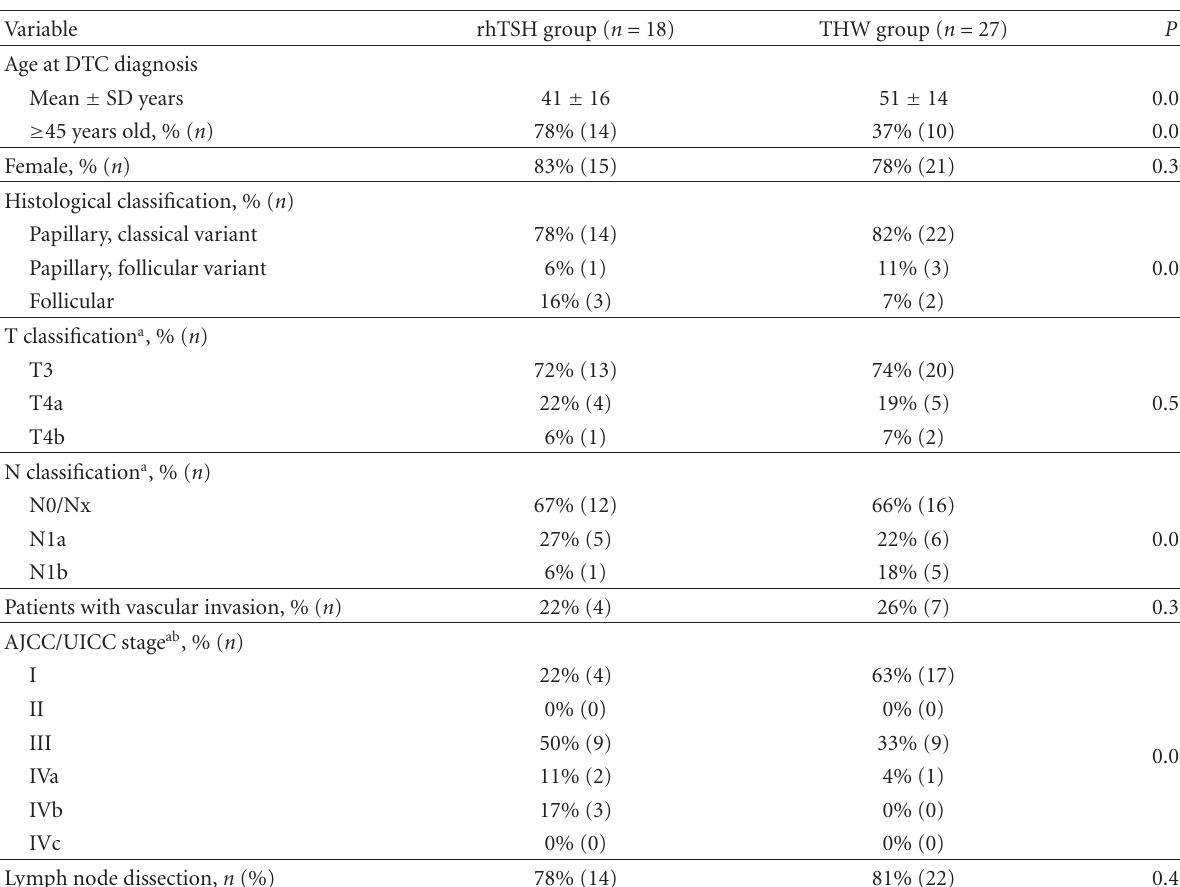
Table 1: (a) Selected patient characteristics by treatment group. (b) Basis for AJCC/UICC staging in the study